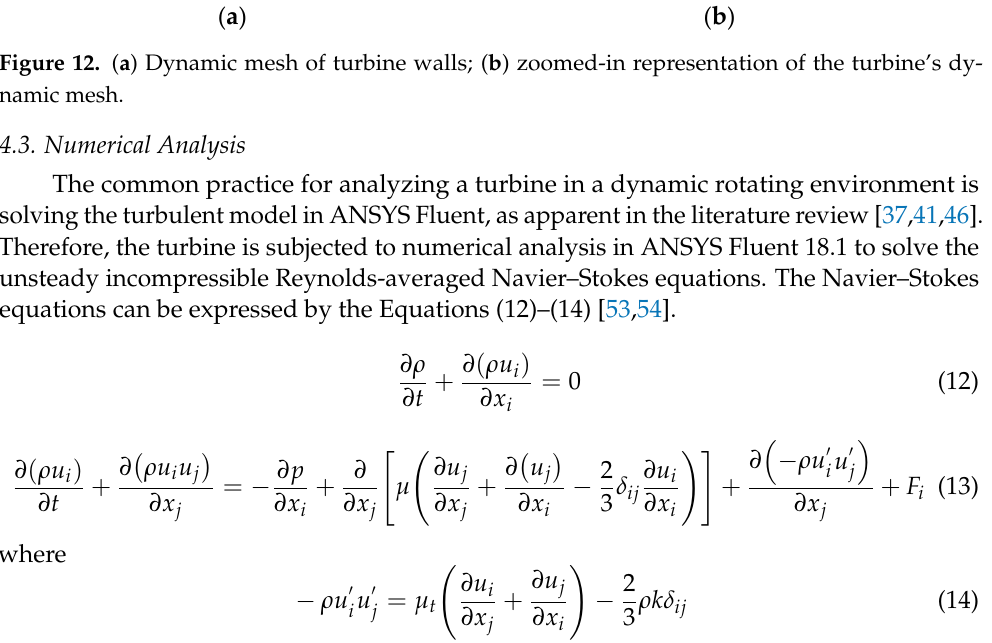
Figure 12. ( a ) Dynamic mesh of turbine walls; ( b ) zoomed-in representation of the turbine’s dynamic mesh.